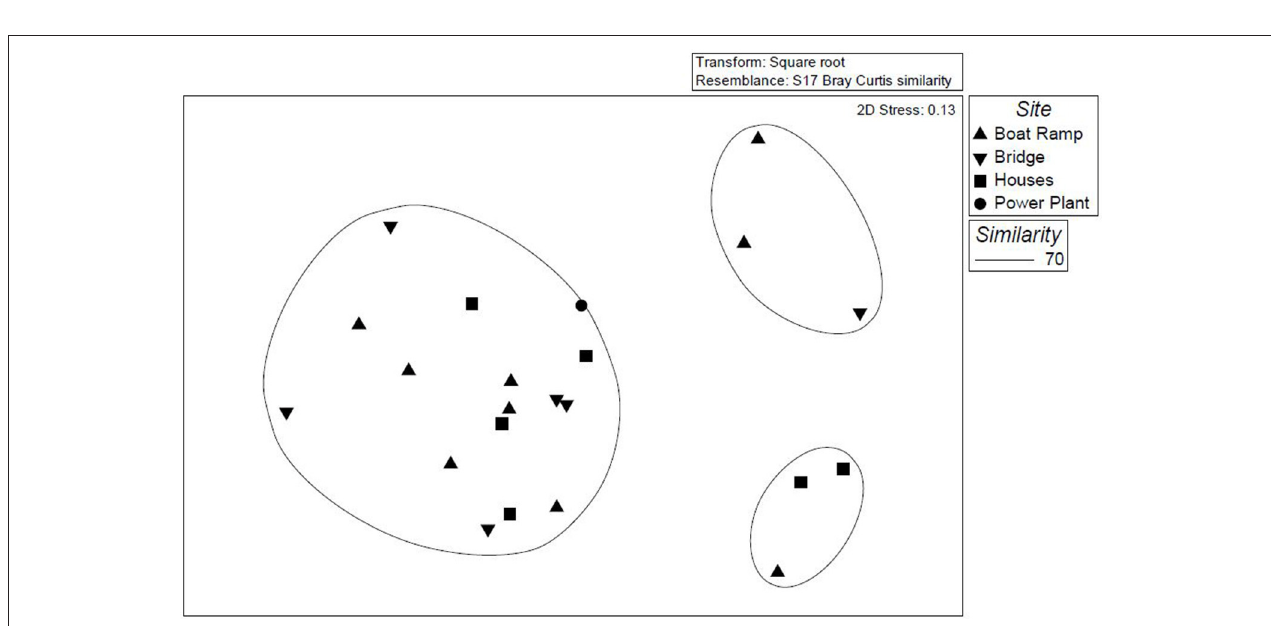
FIGURE 6 | NMDS plot showing relationships between diatom community compositions for each sampling month during 2009 and 2010.